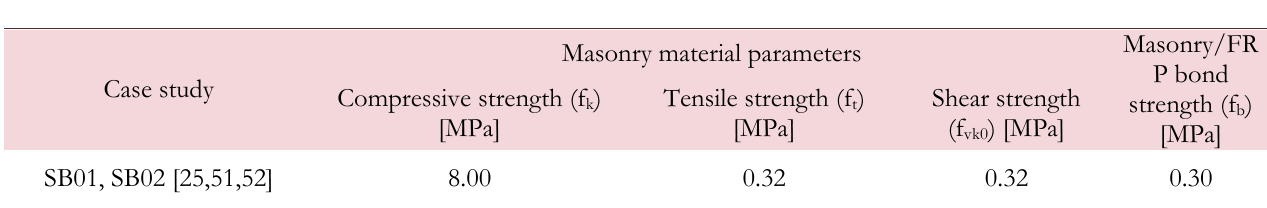
Table 1: Material parameters.